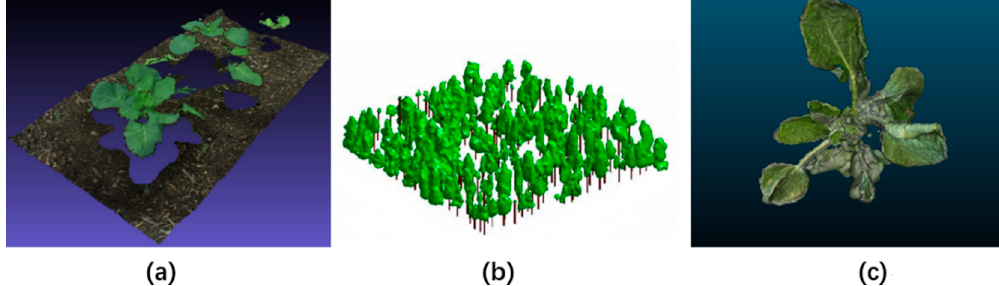
Figure 8. ( a ) Cabbage reconstruction based on Delaunay triangulation [92]; ( b ) Tree reconstruction based on implicit surface reconstruction algorithm [97]; ( c ) Sugar beet reconstruction based